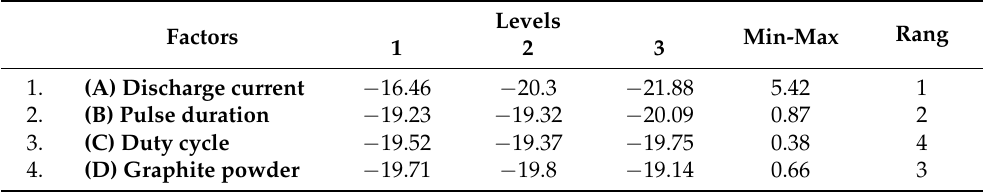
Table 4. Response table of S/N ratio for defect